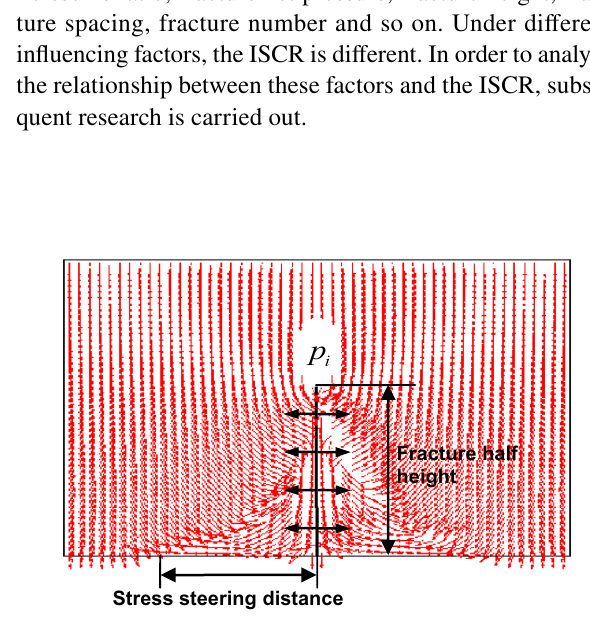
-0.200.20.40.60.8